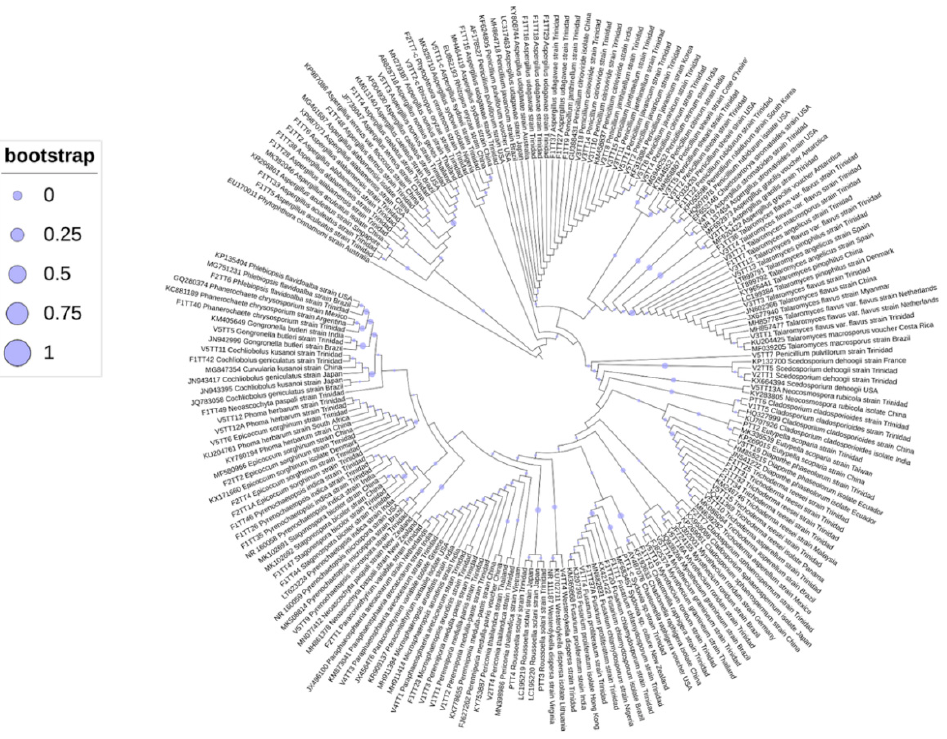
Figure 3. Unrooted ML phylogenetic tree for filamentous fungi.